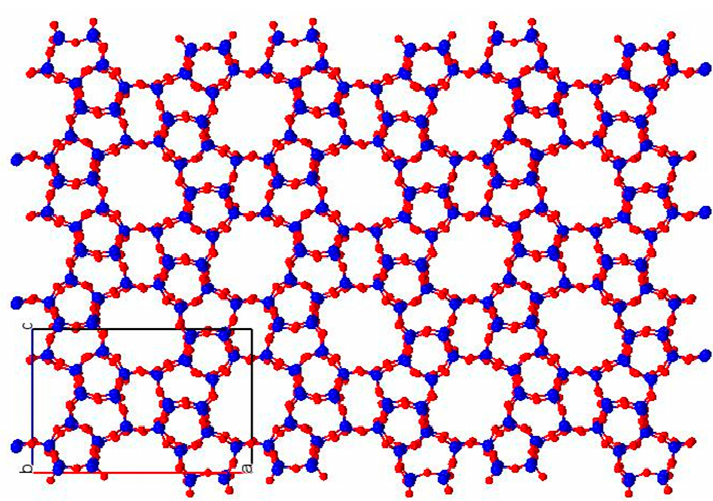
Figure 1. MFI structure along the b-axis, plane (0 -2 0), represented with the program Mercury [11].